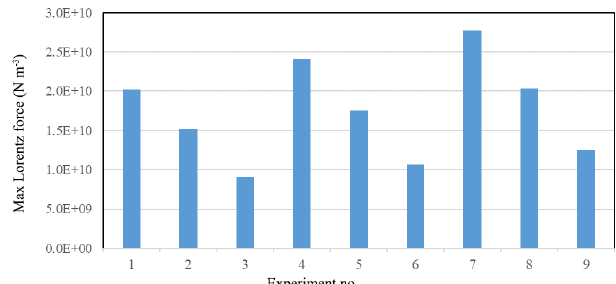
Figure 10. Maximum Lorentz force values for all conditions ob- tained from numerical simulation.